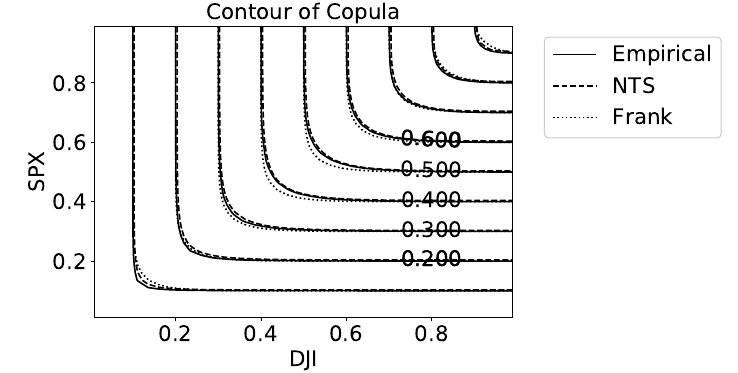
Figure 9. Density of ( a ) the empirical copula and ( b ) the NTS copula.